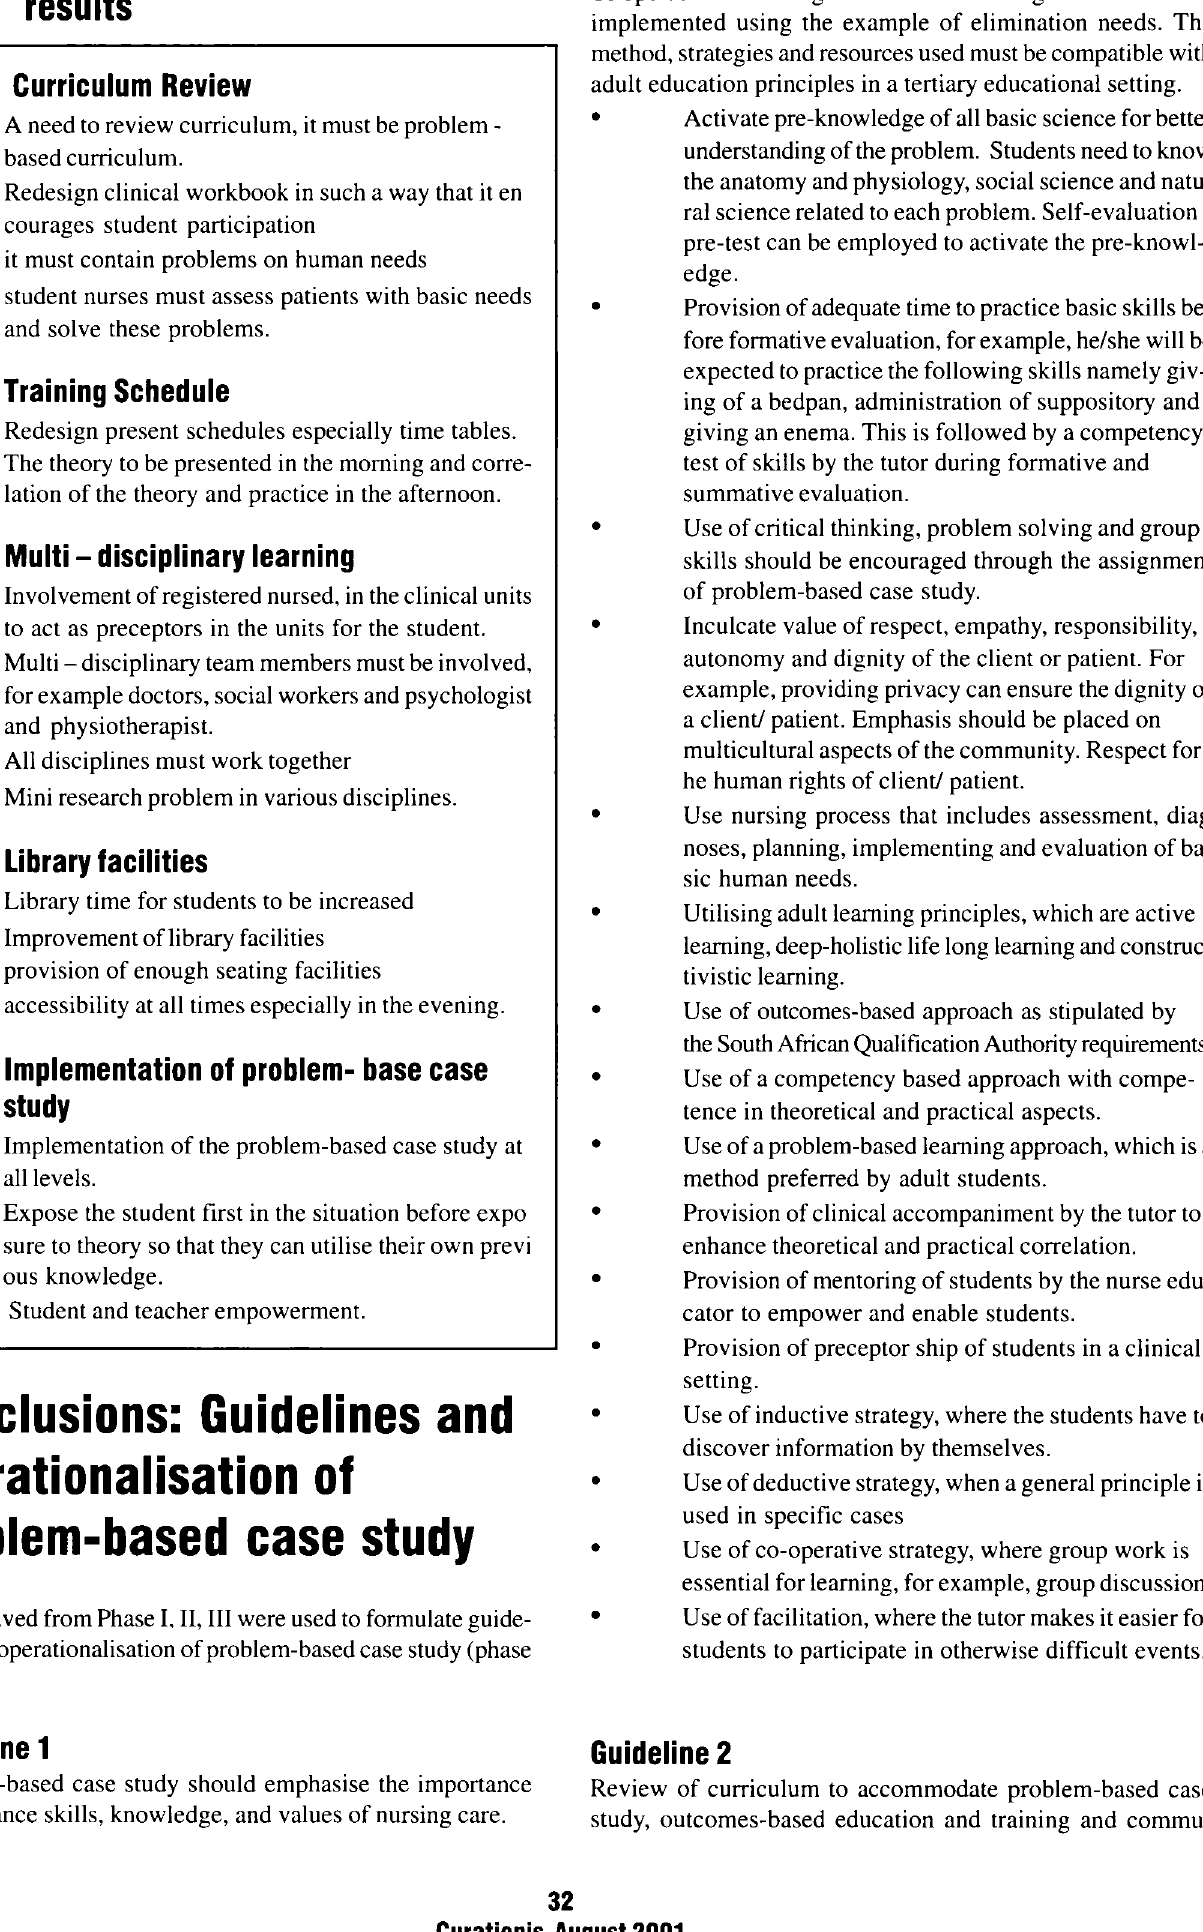
Table 2. Categories of focus group